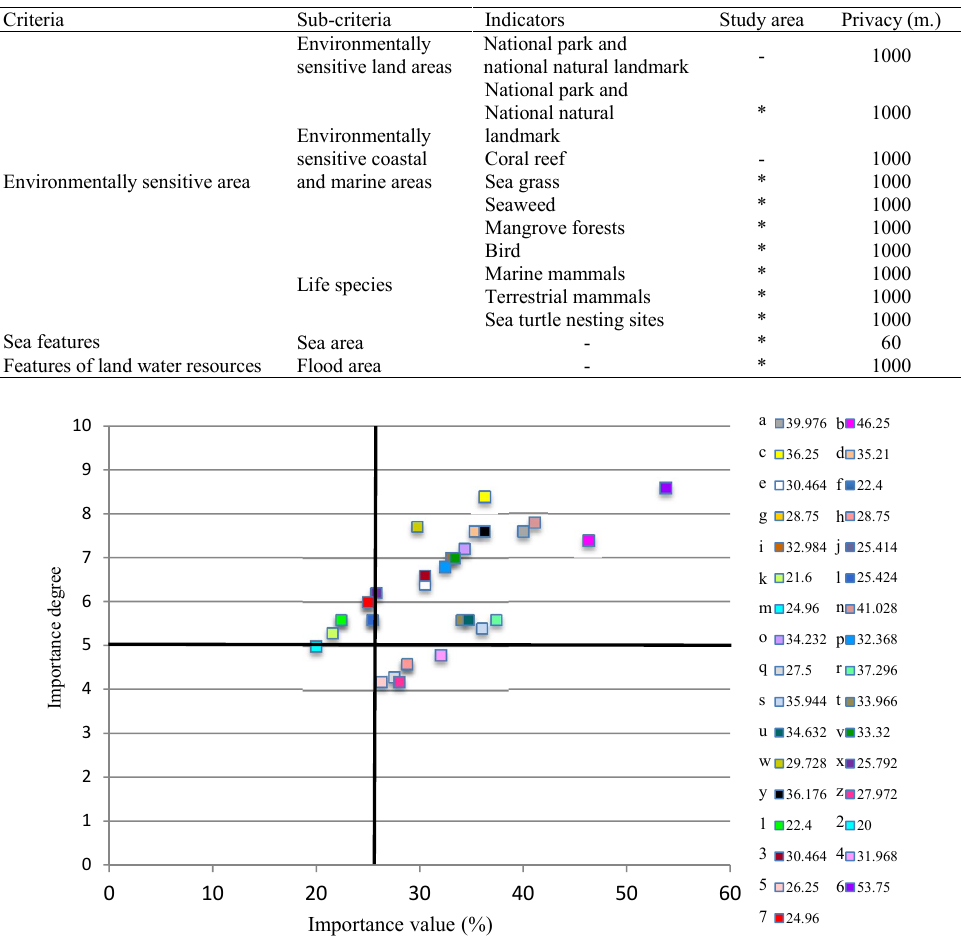
Table 2: The compulsory sub-criteria identified